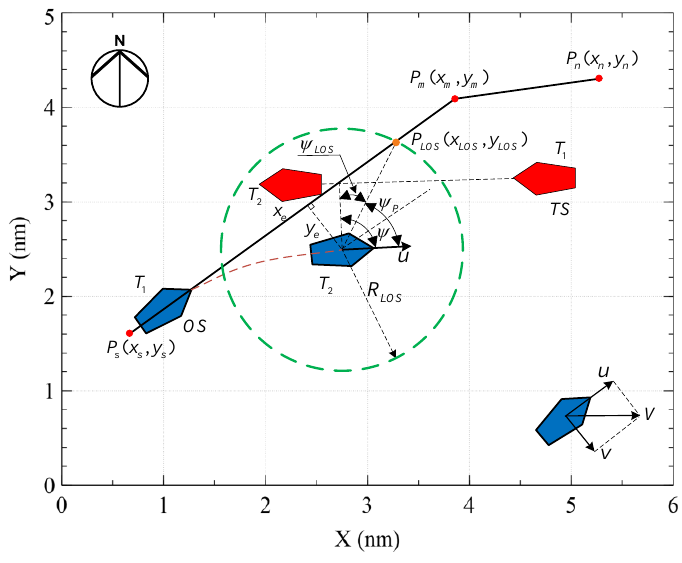
Figure 4. The LOS guidance strategy.